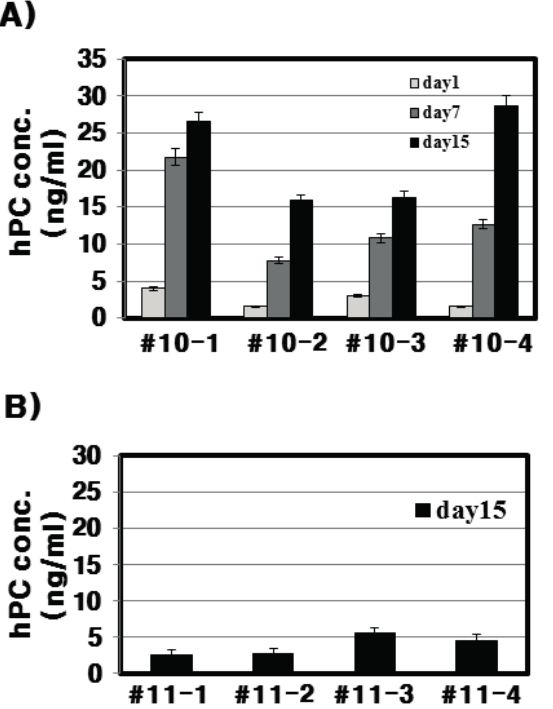
Figure 6. The quantity of rec-hPC in the Tg mice milk by ELISA. ( A ) rec-hPC in the #10 lines analyzed by ELISA on days 1, 7, and 15 during lactation; ( B ) hPC analysis in the #11 line. Each point and vertical bar represents the mean and standard error of the mean (SE) values, respectively, for the three different